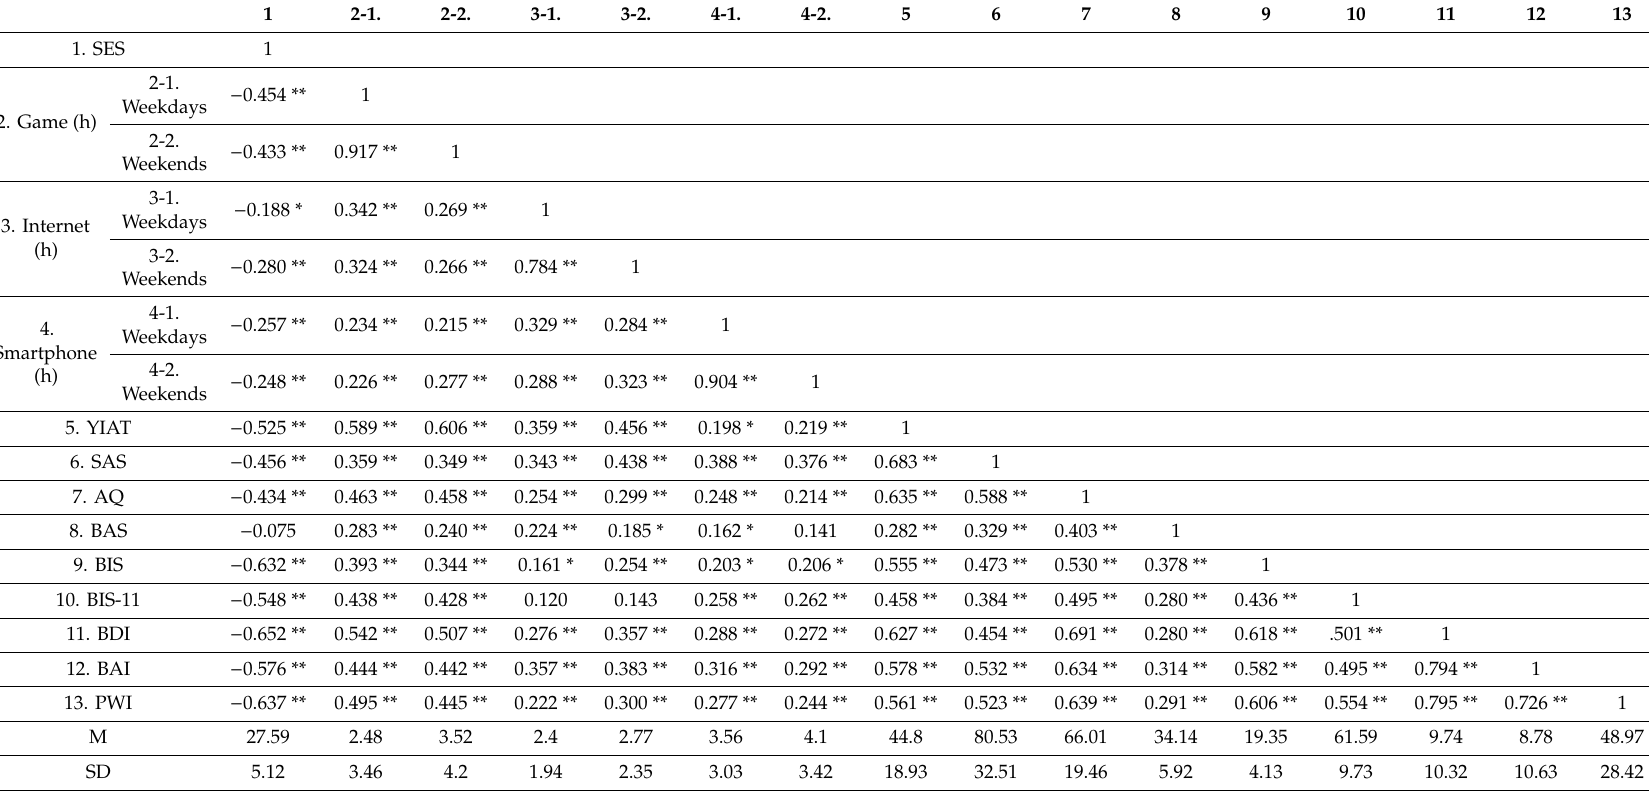
Table 2. Correlation Self-e ffi cacy and clinical characteristics in total